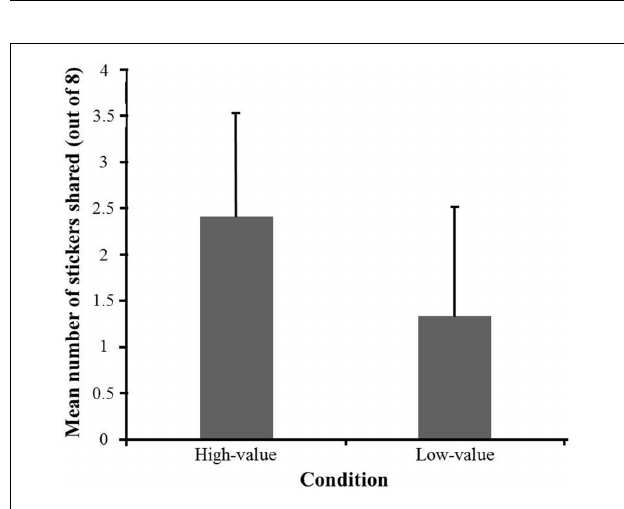
FIGURE 5 | The mean number (and standard deviation) of stickers shared in the two conditions in Experiment